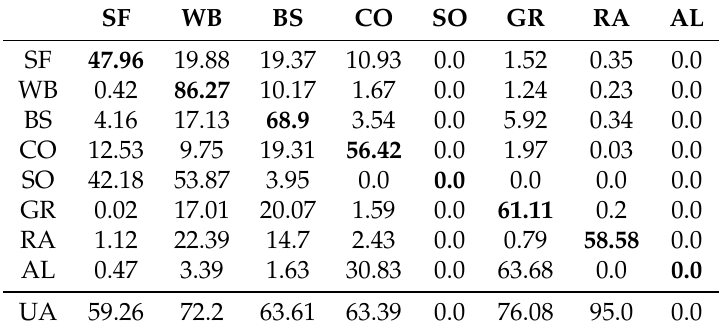
Table 8. Confusion matrix for 29-01-2015 using Sentinel-1 (3 images) and Landsat8 (4 images). κ =